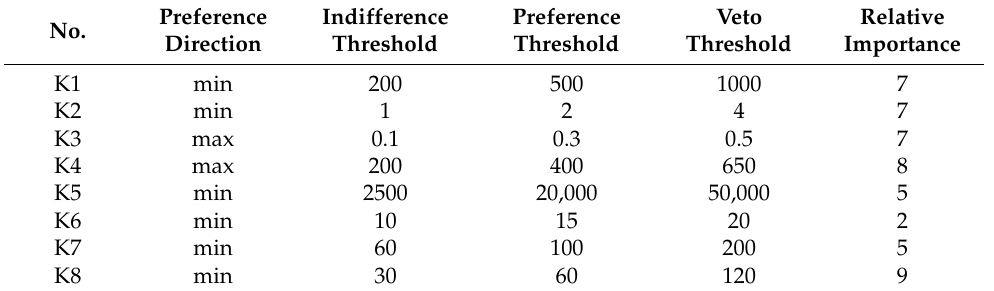
Figure 5. Final rankings, outranking, credibility and concordance matrices for the experts’ preference models: ( a ) E1, ( b ) E2, ( c ) E3, ( d ) E4. Table 5. Decision-maker’s preference model—Expert 2—Mine Manager—Mining Operations Manager.